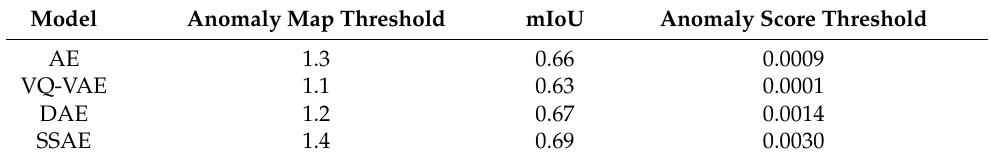
Table 2. Anomaly thresholds for autoencoder anomaly